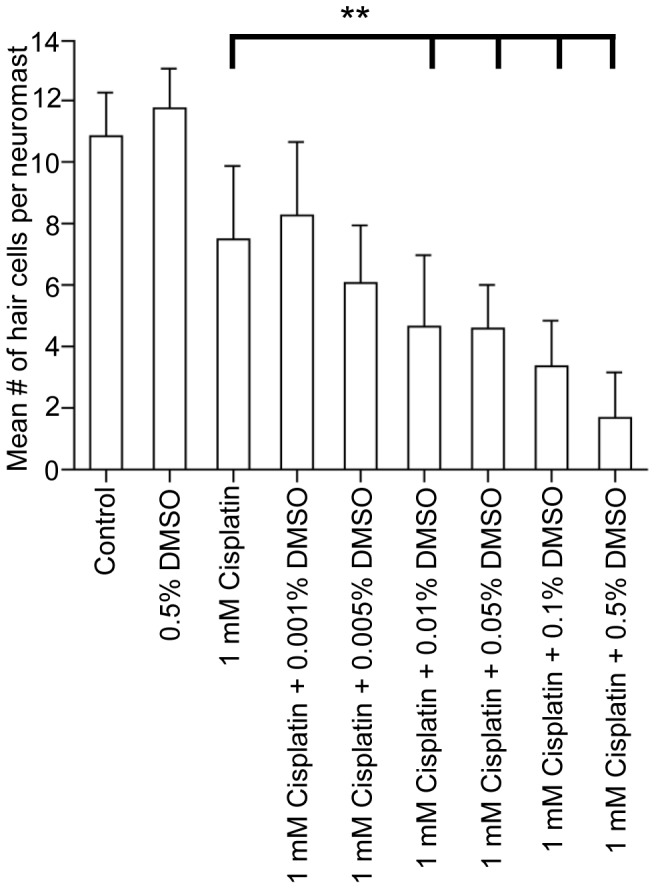
Varying the concentration of DMSO with a constant level of cisplatin affects the number of surviving hair cells present in the neuromast.Brn3c-GFP larvae were treated with either 0.5% DMSO, 1 mM cisplatin or 1 mM cisplatin plus a dose range of DMSO (0.001%–0.5%), fixed, and surviving hair cells in O2 neuromasts were imaged and counted. Increasing the concentration of DMSO reduced the number of O2 sensory hair cells. Larvae treated with 1 mM cisplatin and plus a DMSO dose greater than 0.01% had significantly fewer hair cells than larvae treated with 1 mM cisplatin alone. Results are the mean values ± SD. n = 18−31 neuromasts for each treatment group. **p<0.01 when individual treatments are compared to untreated controls.